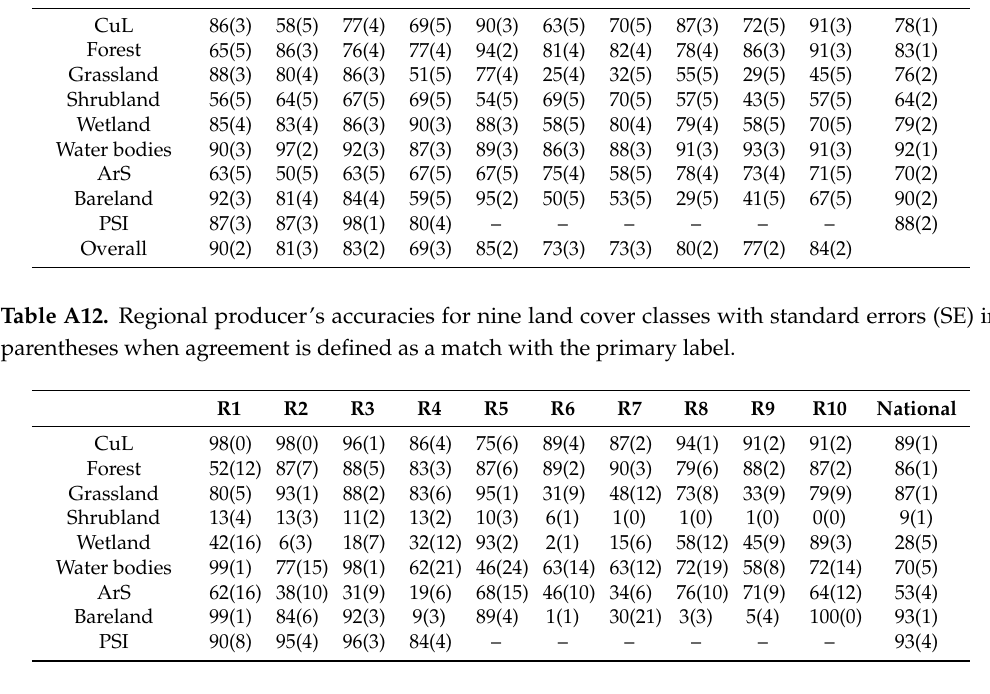
Table A13. The country-wide error matrix; cell entries are expressed as percent of area (see Table 5 for meanings of CuL, ArS, and PSI). Agreement is defined as a match between the map label and the primary reference label. User’s accuracy (UA) and producer’s accuracy (PA) are reported with standard errors (SE) in parentheses. Overall accuracy is 81.0%